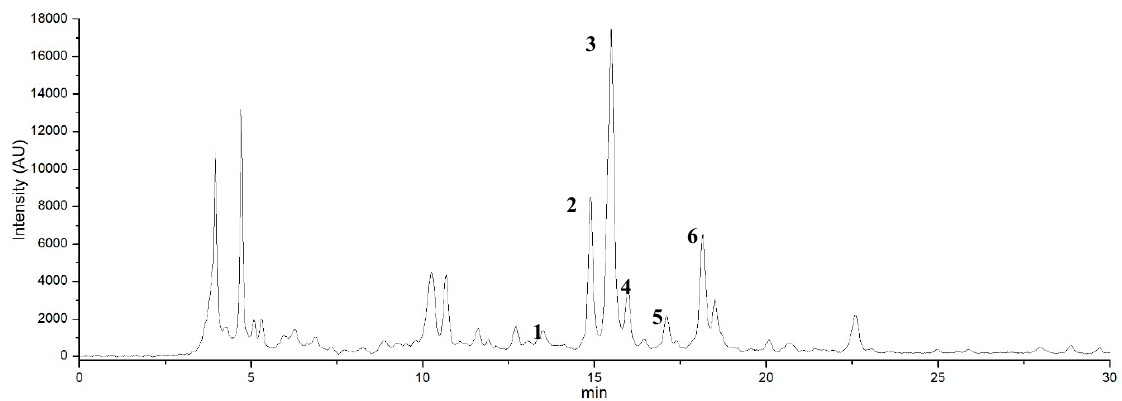
Figure 8. HPLC chromatogram detected at 340 nm the molecules contained in the aqueous extract of the peel of the fruits of Opuntia ficus-indica (L.) Miller obtained by the Extractor Naviglio ® . Peaks 2 and 3 were identified as pigment molecules such as betanin and isobetanin. Peaks 1, 4, 5 and 6 were identified as luteolin, kaempferol, quercetin and isorhamnetin according to the standards available in the laboratory; the other peaks were unknown compounds.